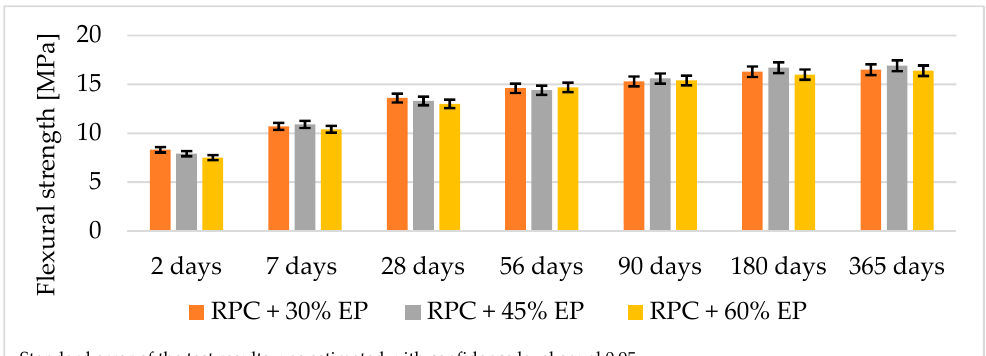
Figure 8. Flexural strength of lightweight RPC containing EP in quantity from 30%, 45%, and 60% by volume.